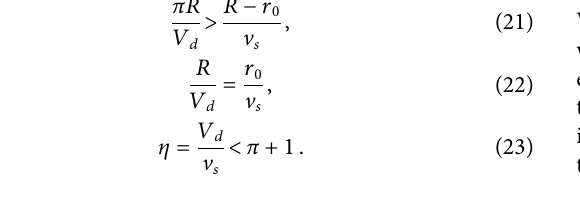
Frontiers in Bioengineering and Biotechnology |